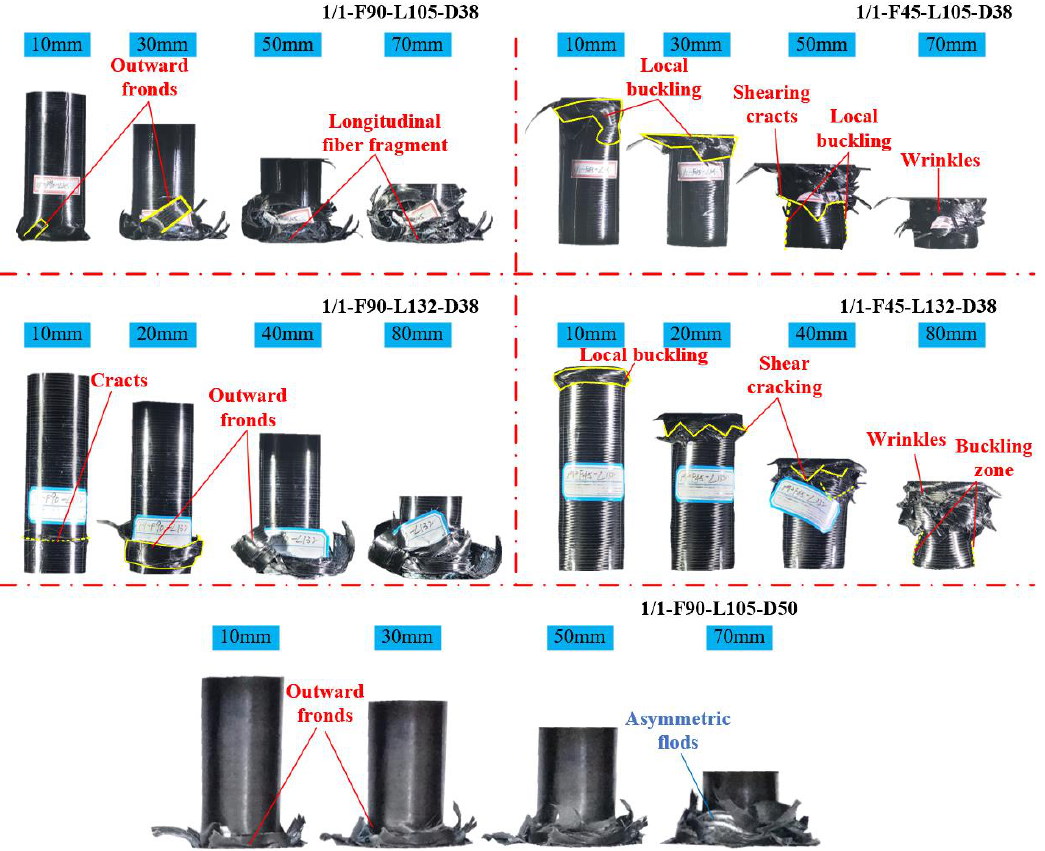
Figure 8. Axial crushing process of 1/1 hybrid tube.